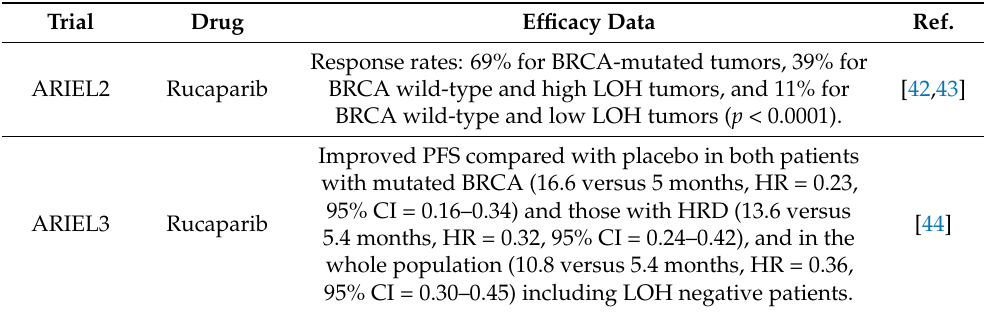
Table 3. Clinical trials evaluating PARPis in first-line ovarian cancer maintenance therapy.